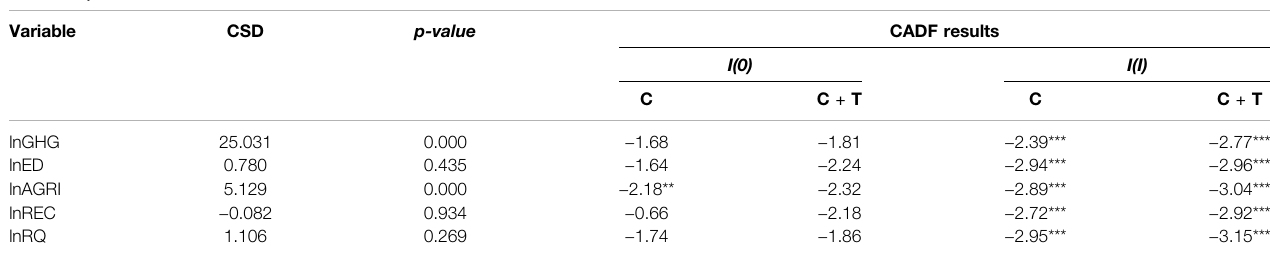
TABLE 3 | Results of CSD and CADF unit root